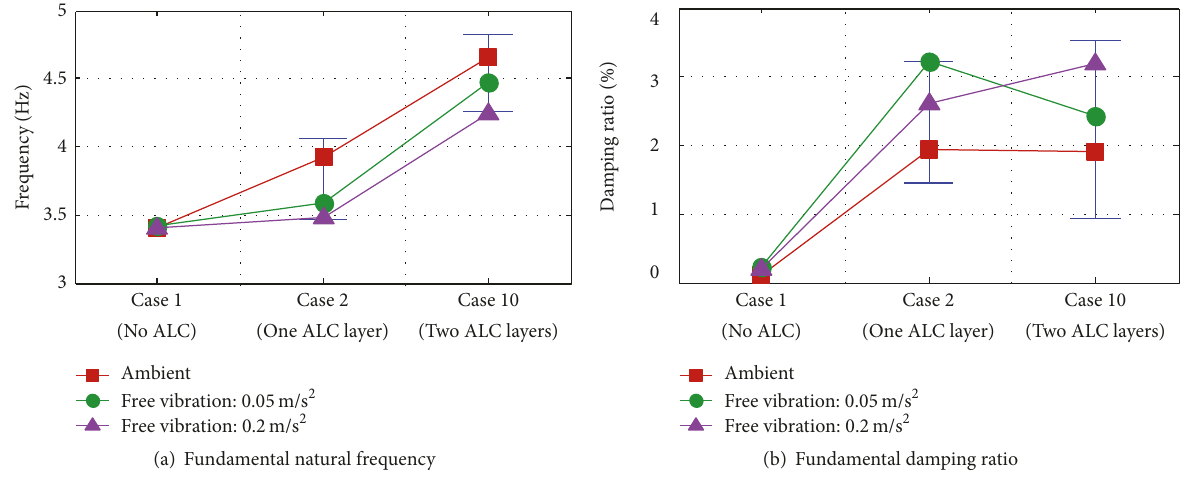
Figure 13: Effect of ALC external claddings on dynamic characteristics of steel